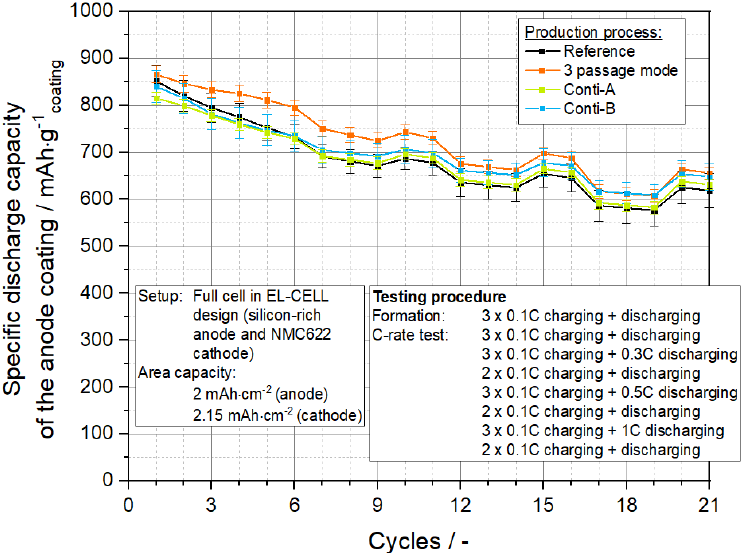
Figure 16. Specific discharge capacities of the silicon-rich anodes, which were produced by four different processes, as a function of the number of cycles during the formation and the C-rate test.